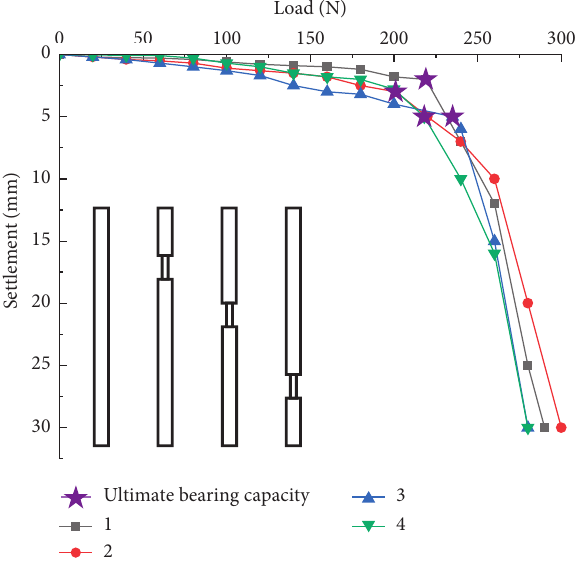
Figure 6: Load-settlement